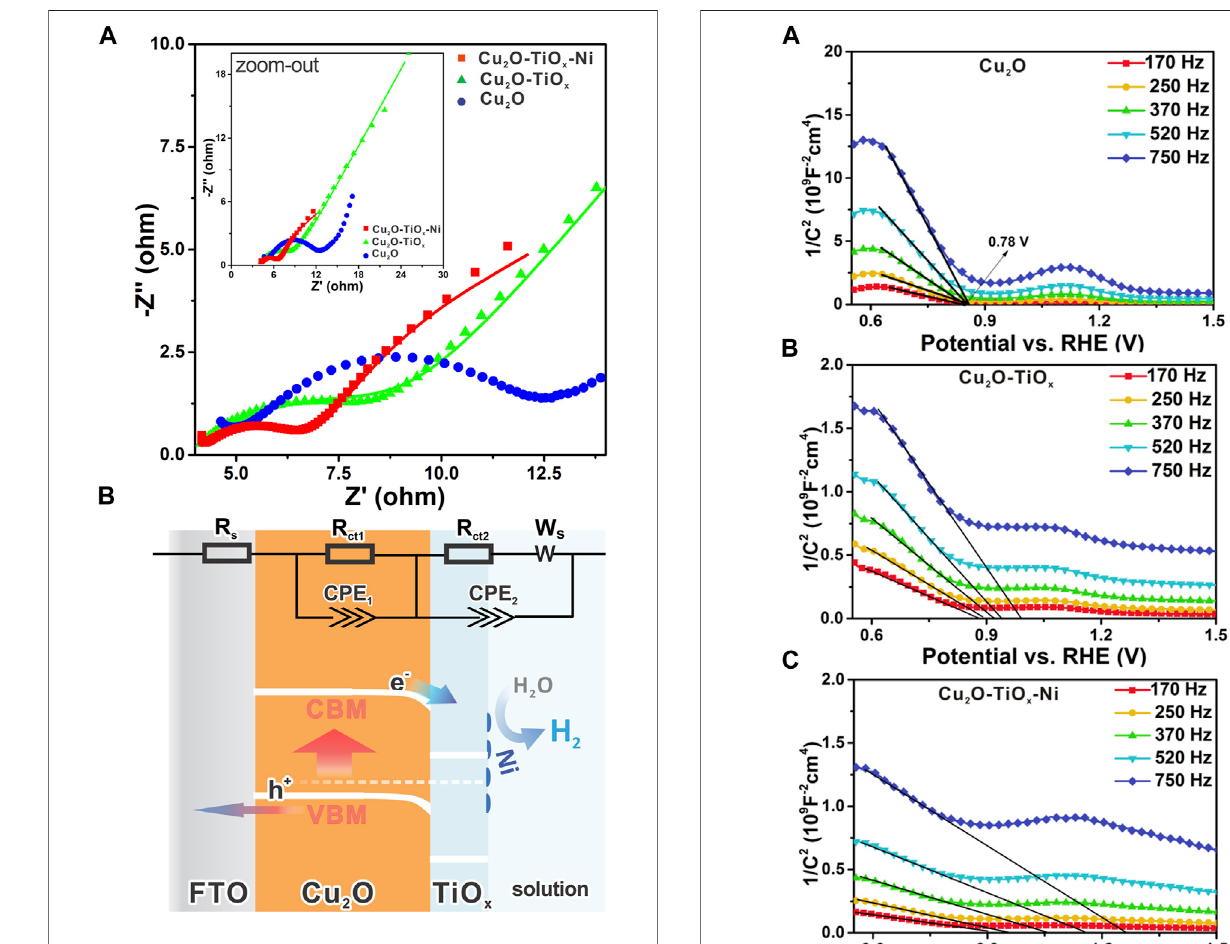
FIGURE 6 | (A) Nyquist plots of different electrodes in 0.5 M phosphate buffer under light irradiation ( λ = 455 nm) with electrochemical impedance spectroscopy at a DC potential of0.5 V vs . Ag/AgCl in ACpotentialfrequency rangeof10to1 Hz,insetshowszoomed-outviewwithfewerdetails; (B) schematic band diagram of Cu 2 O/TiO x /Ni photocathode representinginternal charge transfer direction, with inset showing equivalent circuit for electrochemical impedance spectroscopy analysis.